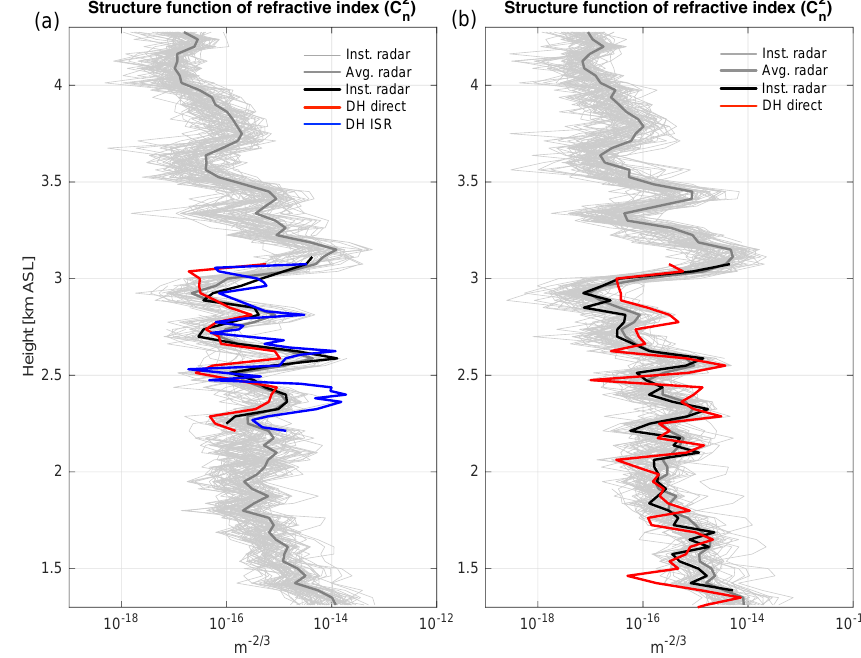
Figure 10. Structure parameter of refractive index obtained during the ascent (a) and descent (b) portions of the morning flight over the SOUSY radar. The light-gray lines represent the multiple C 2 n profiles obtained from SOUSY for the corresponding flight. The thick dark- gray line is the radar average over the same period. The thick black line represents the C 2 n obtained from the radar around the closest times after the DH signature is removed. The thick red line represents C 2 n obtained from the DataHawk estimated for a distance corresponding to the Bragg scale ( λ B = 2.8m). Finally, the thick blue line represents C 2 n estimated within the ISR but only estimated for the ascent portion of the flight.